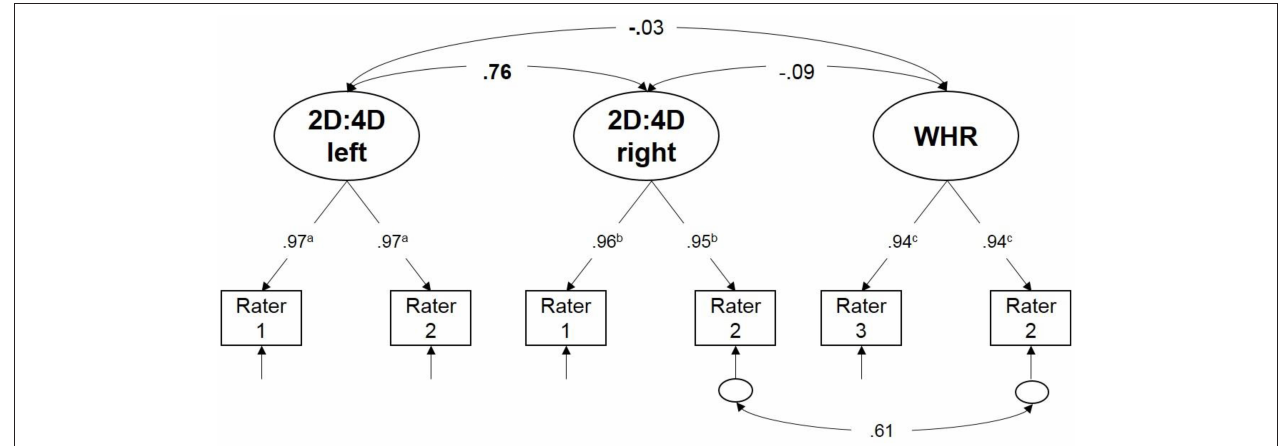
FIGURE 2 | Schematic representation of the measurement model of prenatal and pubertal organizational effects of hormones. Rectangles represent measured variables and circles are used to depict latent variables. 2D:4D at the left and the right hand was measured by two different raters. Rater specific values are used as measured variables to estimate latent variables that represent prenatal and pubertal organizational effects accounted for measurement error due to the rater. Unidirectional path represent factor loadings and bidirectional path are used for depicting correlations. Short arrows (with a small circle) represent residual variance (non-reliability of a measured variables). For simplicity, we use only arrows to indicate error variance if there is no residual correlations between residuals. 2D:4D left—left hand 2D:4D estimation taking rater induced measurement error into account; 2D:4D right—right hand 2D:4D estimation; WHR—facial width-to-height ratio estimate taking rater induced measurement error into account; a, b, c indices on factor loadings are used to indicate that non-standardized loadings were fixed to equality within factors; standardized loadings are depicted in the figure. Significant relationships between latent factors at p < 0.05 are written